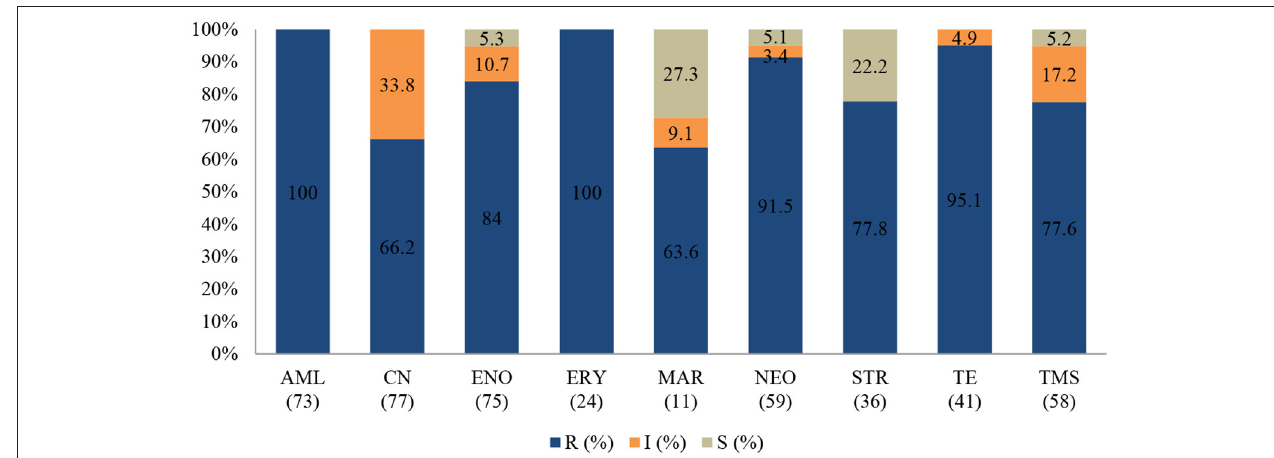
FIGURE 6 | Antibiotic susceptibility pattern of Escherichia coli isolates from diseased non-ruminants (January 2015-December 2017). R-resistance; I-intermediate; S-susceptible; AML-amoxicillin; CN-gentamicin; ENO-enrofloxacin; ERY-erythromycin; MAR-marbofloxacin; NEO-neomycin; STR-streptomycin; TE-tetracycline;